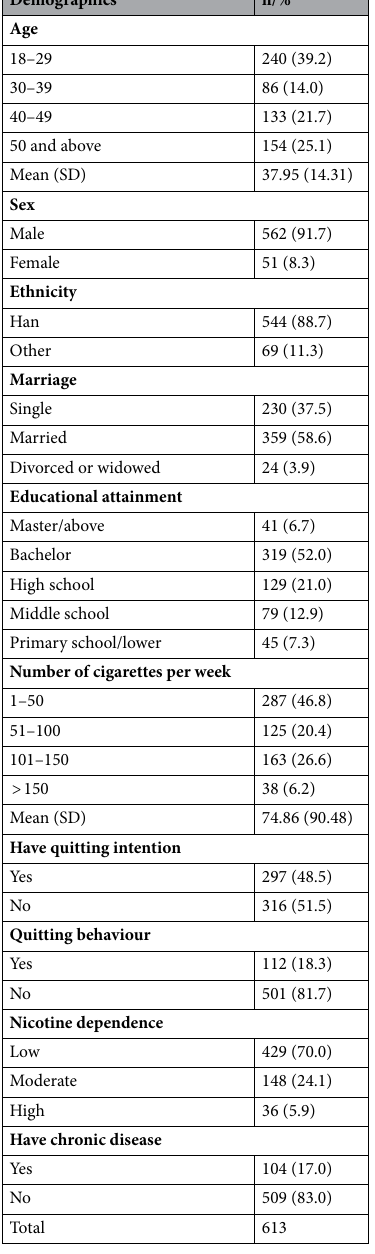
Table 1. Descriptive statistics for the overall